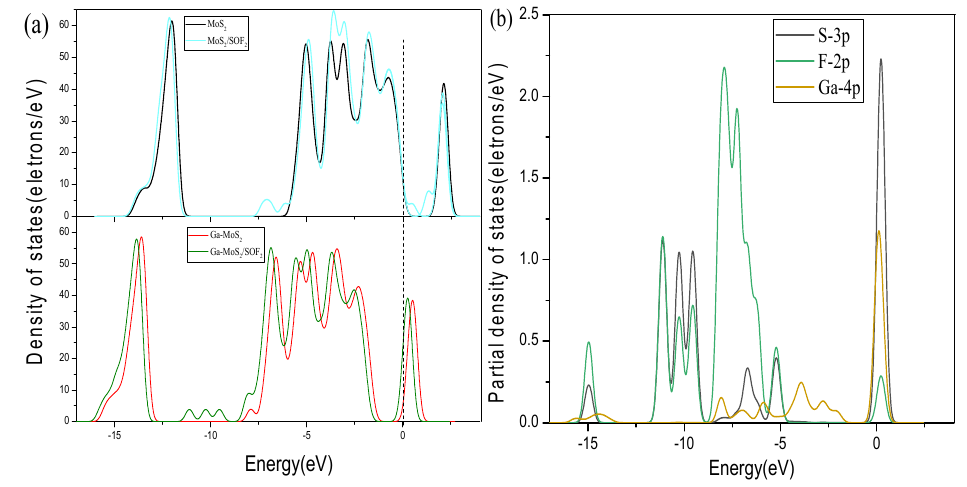
Figure 10. Comparative analysis of ( a ) DOS and ( b ) PDOS for SOF 2 system. The dotted lines are Fermi level.